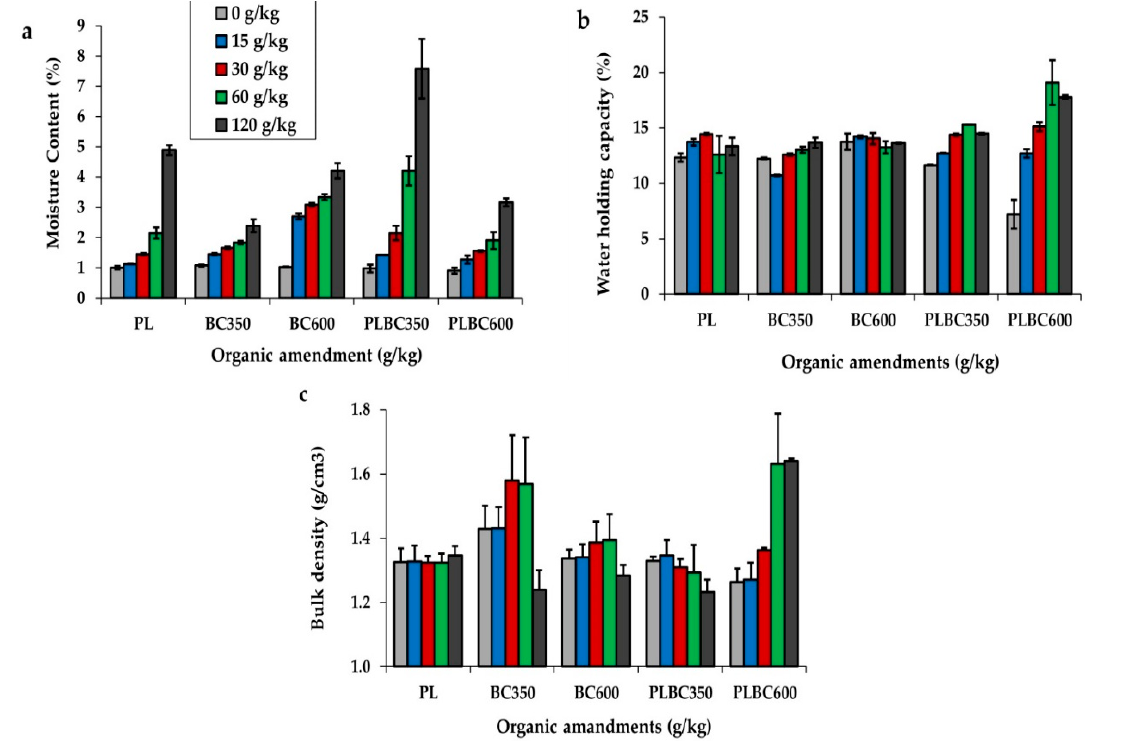
Figure 2. Effects of poultry litter and its biochar on ( a ) Moisture content (%), ( b ) Water holding capacity (%) and ( c ) Bulk density (g/cm 3 ) at different application rates of 0, 15, 30, 60, and 120 (g/kg). Graphs represent mean and standard error, n = 3.